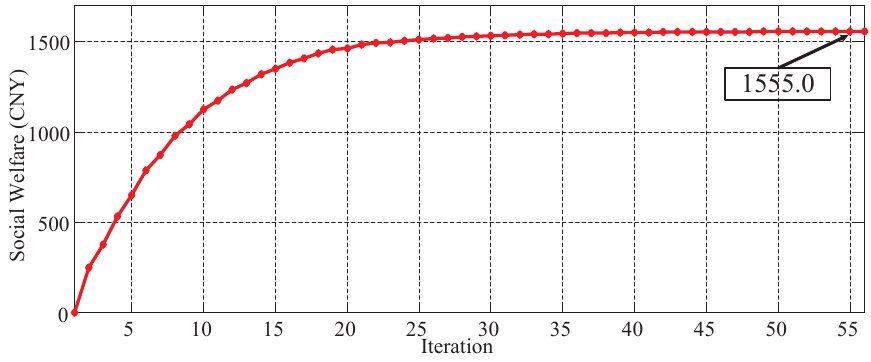
Figure 5. Convergence results of total social